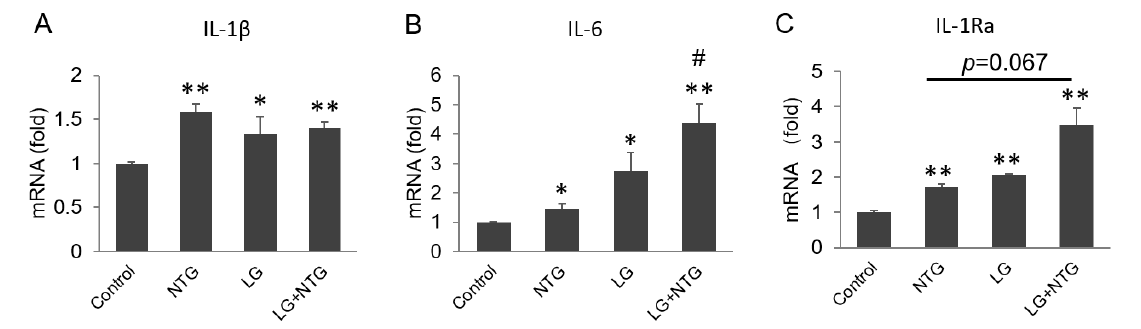
Figure 3. More inflammatory factors are produced in low-glucose group. Astrocytes were collected after treatment with different concentrations of glucose and NTG (2 μg /mL) for 4 h. mRNA levels of IL- 1β, IL -6 and IL-1R were detected by qRT-PCR. ( A ) Both NTG and low glucose induced IL-1 β production. ( B ) IL-6 was induced by NTG and low glucose. ( C ) IL-1Ra was induced by NTG and low glucose. Compared with control, * p < 0.05, ** p < 0.01. Compared with NTG, # p < 0.05.